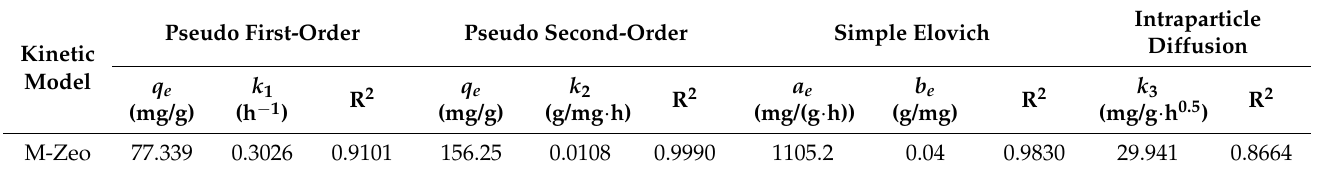
Table 4. Kinetic parameters of ammonium adsorption by M-Zeo.